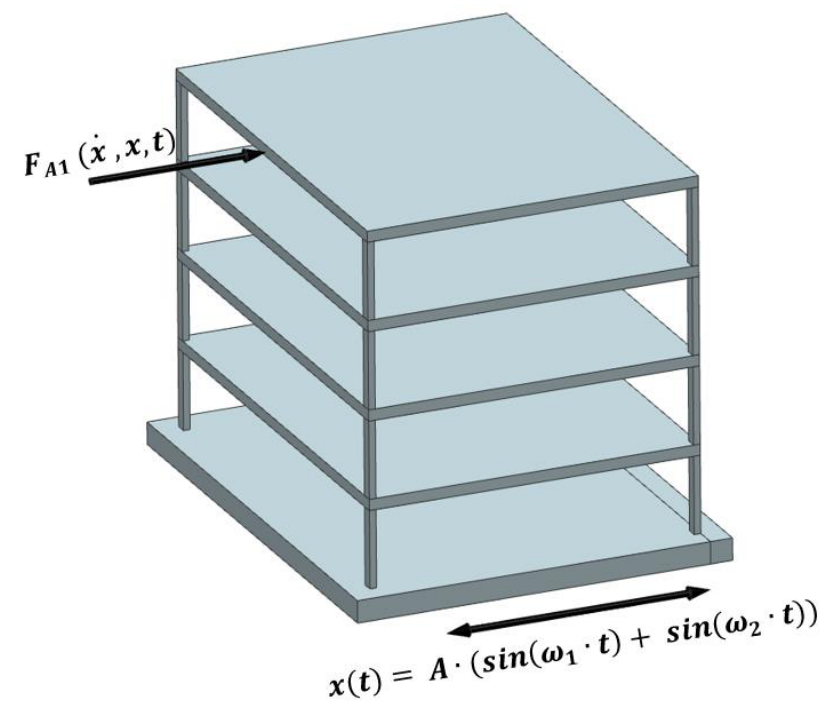
Figure 10. The applied excitation in the second analyzed case. Since the active 𝐹 𝐴1 force is a variable in time and depends on the displacements and their velocities, the values of which are time dependent; therefore, to simulate the process of active vibration damping in the analyzed building, a feedback had to be entered to the model by the use of markers and sensors. They allow to read the displacements and their velocities in each story in time and the excitation. As regards the